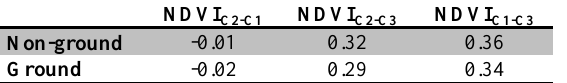
Table 7. NDVI_thrd values obtained from Jenks natural breaks